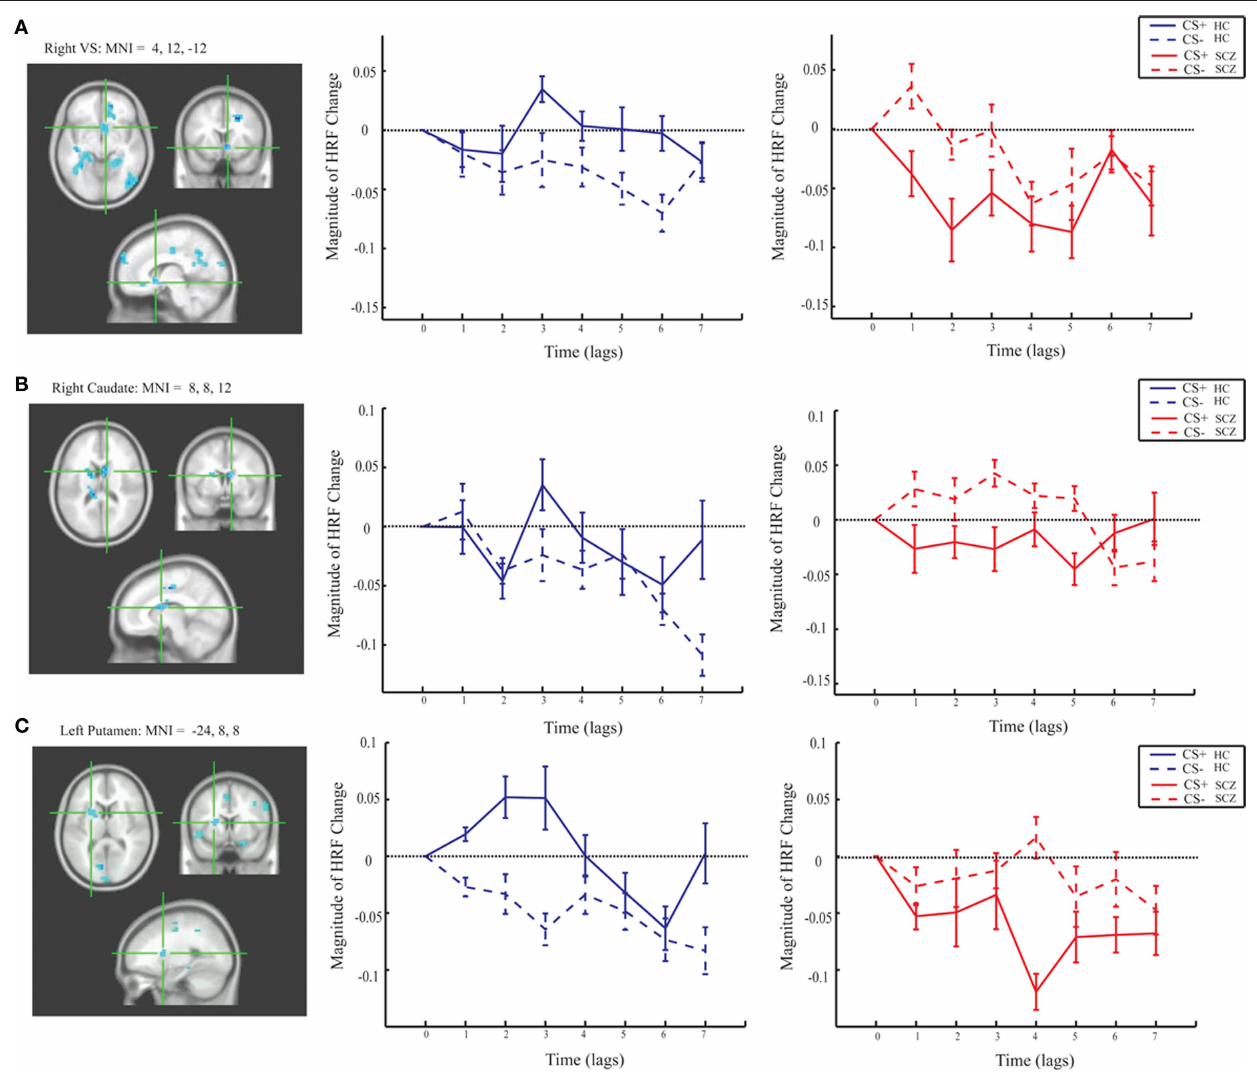
FIGuRe 3 | Magnitude HRF for the striatum from group task PLS analysis (LV 1). (A) right VS [MNI coordinates ( x , y , z ): 12, 10, − 12]; (B) right caudate (MNI: 8, 7, 10); and (C) left putamen (MNI: − 24, 8, 8) showed increased activity to the CS + compared to the CS − in the control group, and increased activity to the CS − compared to the CS + in the patient